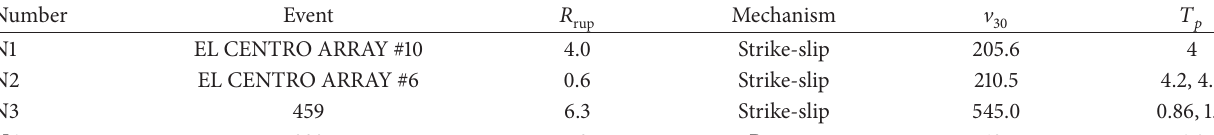
Table 2: Near-fault pulse-like record data.